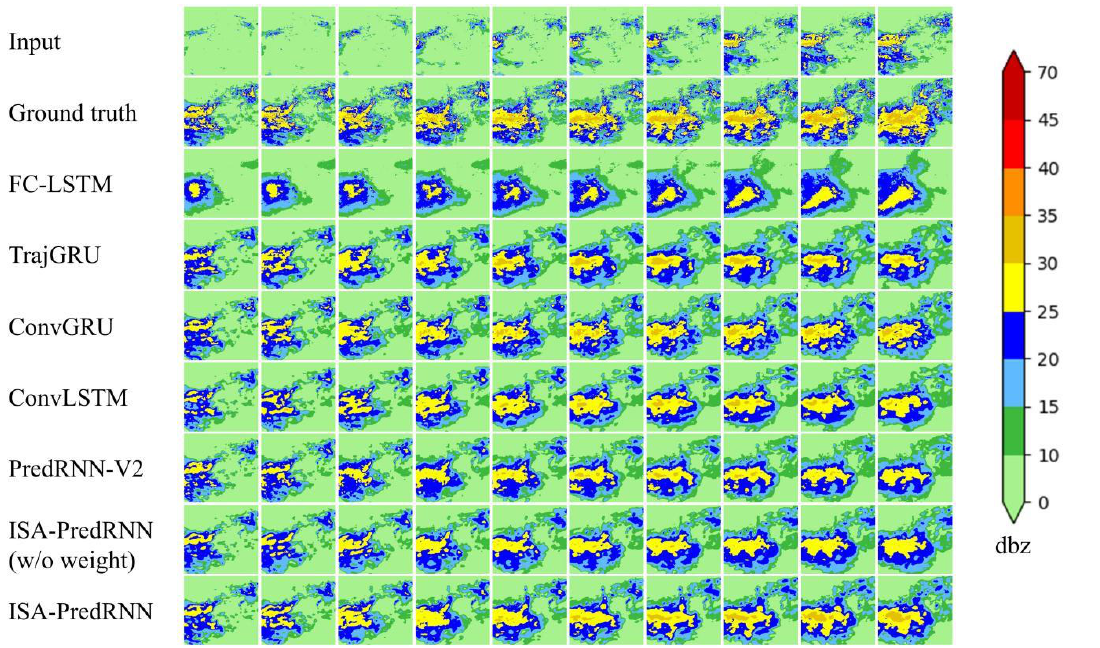
Figure 8. Prediction examples on the radar echo test set, in which the radar echo was not as strong as that in the first one but changed greatly. that in the first one but changed